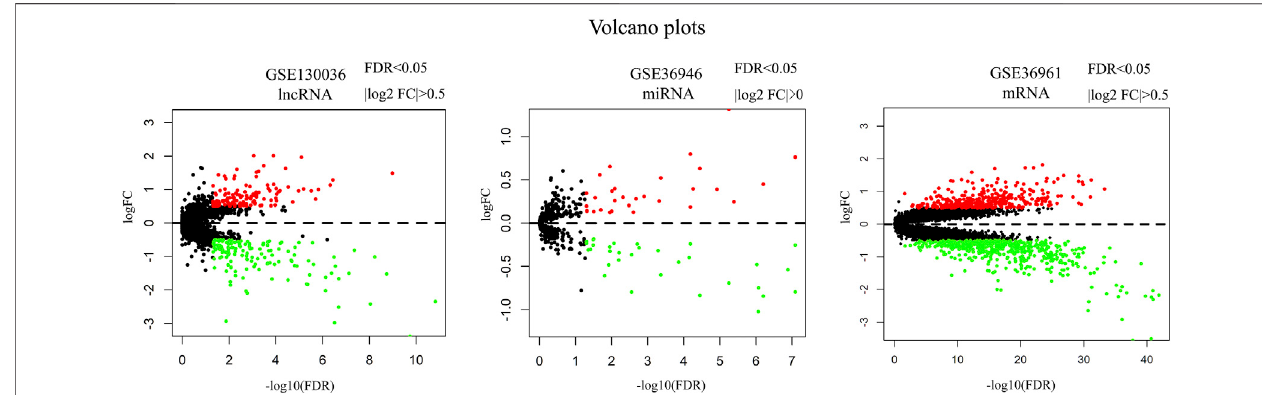
FIGURE 1 | Volcano plots of differentially expressed lncRNA, miRNA and mRNA. Red dots represent upregulated genes. Green dots represent downregulated genes. Note: FC, fold change.